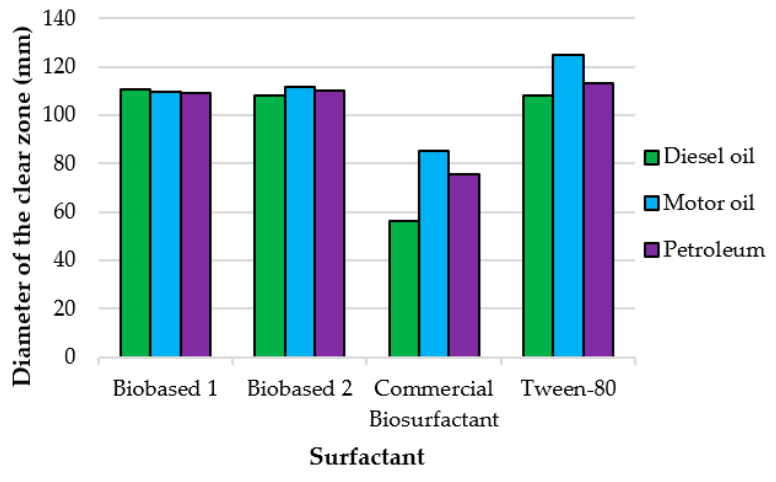
Figure 3. Diameters of the clear zones, on the oil surface, produced in the displacement test on the three types of oils by the tested surfactants. Results are expressed as means ± SD ( n = 3) where means are significant at p < 0.05.